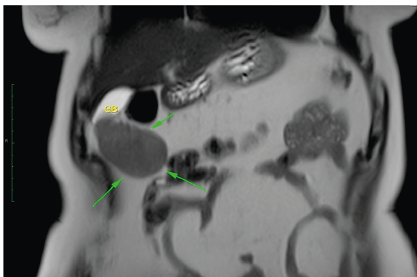
Figure 1: Coronal T2-weighted image. The mass extending from the gallbladder (arrows) and the gallbladder (GB) are seen.